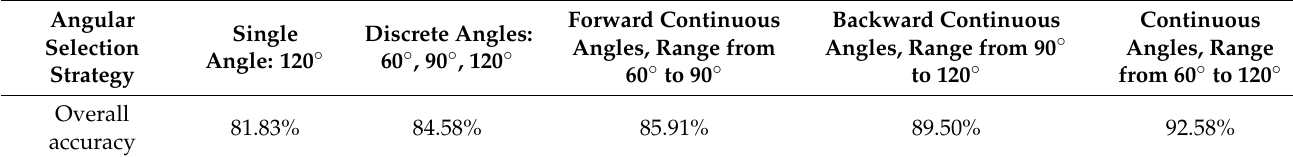
Table 1. Comparisons of the overall